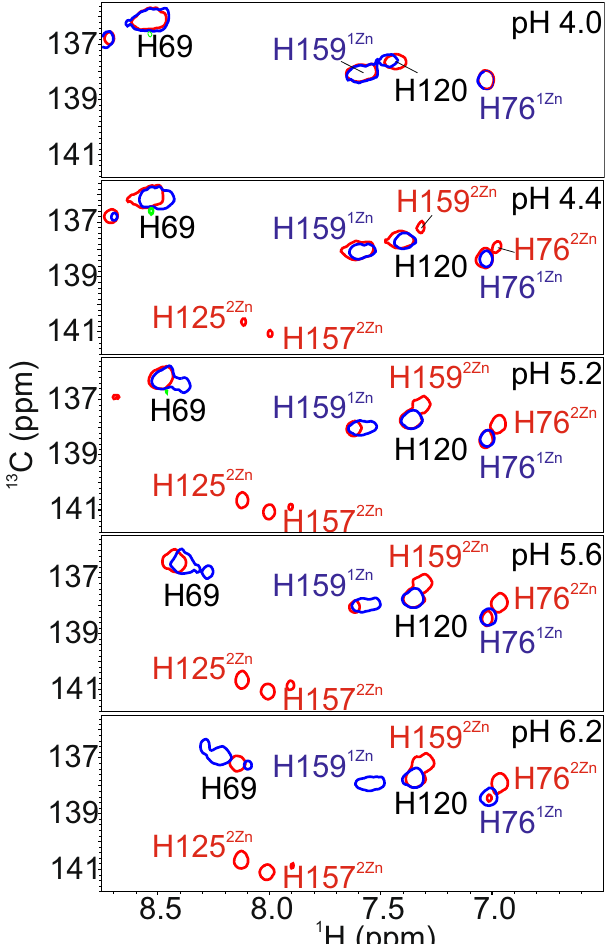
Figure 6. pH dependence of the second zinc binding. 1 H, 13 C HSQC spectra encompassing the aromatic peak region were acquired for one- and two-zinc LytU with ~0.4 pH unit intervals. Only titration figures at the lower end of the range (4.0–6.2) are provided due to the lack of differences at higher pH values. Shown are the overlays of the histidine ε 1 region of one- and two-zinc LytU spectra at different pHs. One-zinc LytU is represented with blue contours and two-zinc LytU with red contours. At low pH, the C ε 1 -H ε 1 regions of the 1 H, 13 C HSQC spectra of one- and two-zinc LytU are identical: H76 and H159 ε 1 peaks have same positions and no peaks are observed for H125 or H157. When pH is raised, H76 and H159 ε 1 peaks at positions corresponding to the two-zinc form appear and gain intensity. In addition, H125 and H157 ε 1 peaks emerge. At pH 5.2 the one- and two-zinc His ε 1 peaks have approximately equal intensity, and at pH over 6.5 one-zinc LytU disappears from the two-zinc LytU